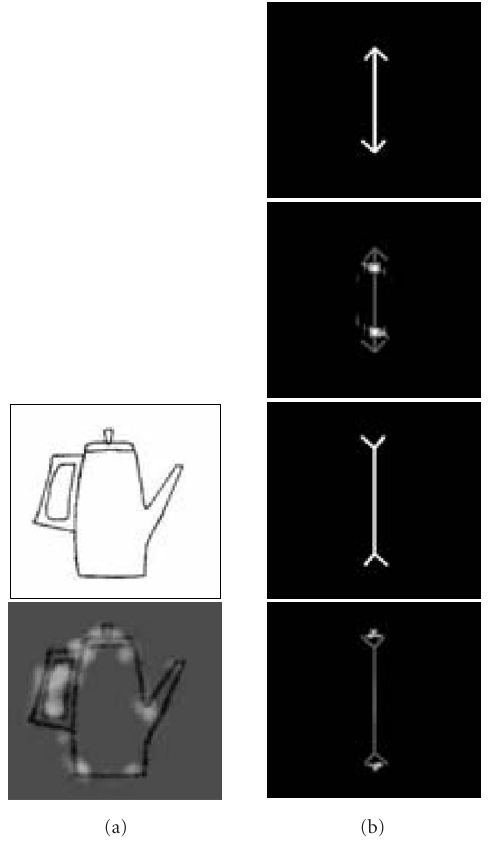
Figure 3: Bottom-up detection of interest points. (a) Detection of interest points is made on the basis of curvature and termination characteristics. (b) The energy peak from these detectors is located inside the direct arrowheads and outside the reversed arrowheads, as expected in the M¨uller-Lyer illusion where the direct arrowheads appear shorter than the reverse